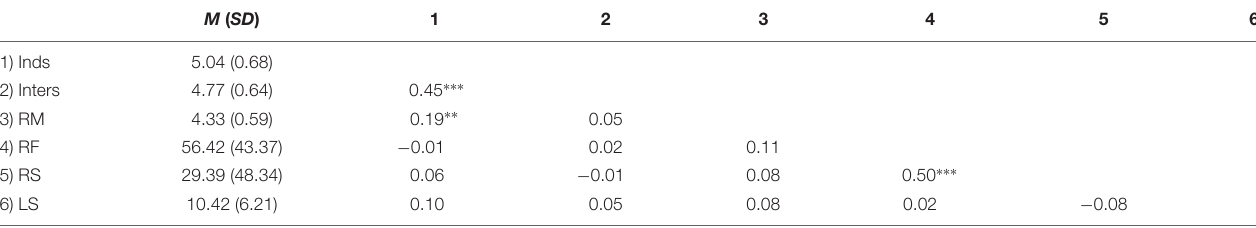
TABLE 3 | Descriptive statistics and correlation results of length of stay in Shenzhen and individualistic